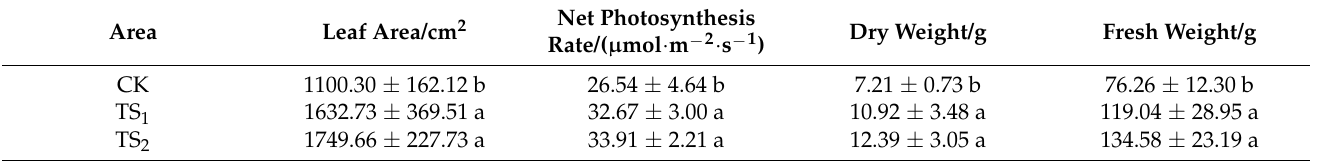
Table 4. Effects of WCTRZSCS on leaf area, fresh and dry weight, and net photosynthetic rate.